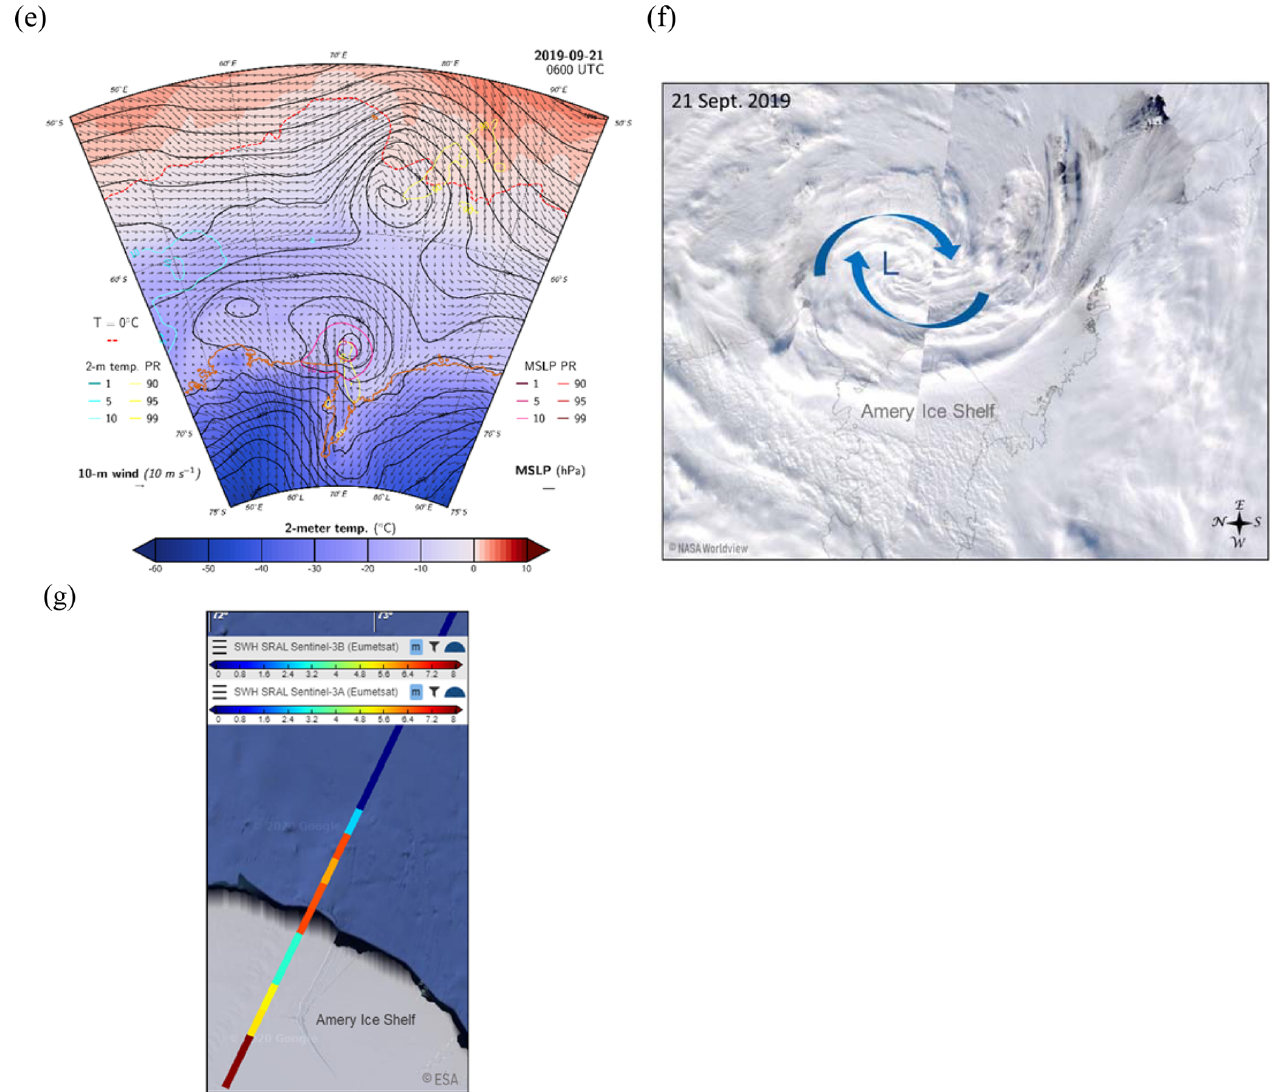
Figure 4. ERA5 reanalysis of (b) MSLP in colors and winds at 925hPa in vectors on 19 September 2019 at 22:00UTC; (b) 2m temperature in colors, with winds at 925hPa in vectors, MSLP in black contours and 0 ◦ C contour in red on 19 September at 22:00UTC; (c) total column water vapor (TCWV) in colors, with winds at 925hPa in vectors and MSLP in black contours on 20 September 2019 at 00:00UTC; (d) standardized anomalies (std. anoms) relative to the full record (1979–2019) of 10m u -wind values on 20 September 2019 at 00:00UTC. Vectors show 10m wind anomalies; black contours show positive MSLP anomalies; and dashed black contours show negative MSLP anoma- lies. Colored contour lines show percentile rank (PR) extremes (1st, 5th and 10th as well as 90th, 95th and 99th percentile ranks) of the corresponding quantities indicated on the plots; (e) 2m temperature in colors, with 10m winds in vectors, MSLP in black contours and 0 ◦ C contour in red dashed-line on 21 September at 06:00UTC. (f) MODIS visible imagery on 21 September 2019; image credit: NASA Worldview. (g) Sentinel-3A and Sentinel-3B observations of wave height on 22 September 2019 at 00:00UTC; image credit: ESA Ocean Virtual Laboratory. Please note that the date format used in this figure is year month day